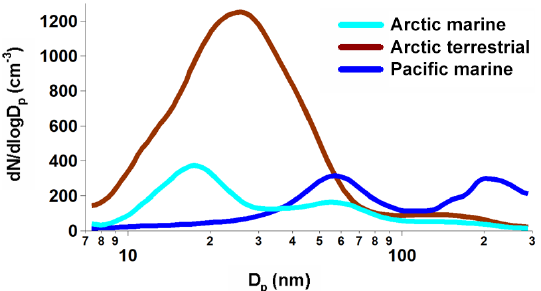
Figure 7. Average size distributions of aerosol particles for Arctic marine, Arctic terrestrial and Pacific marine air masses.